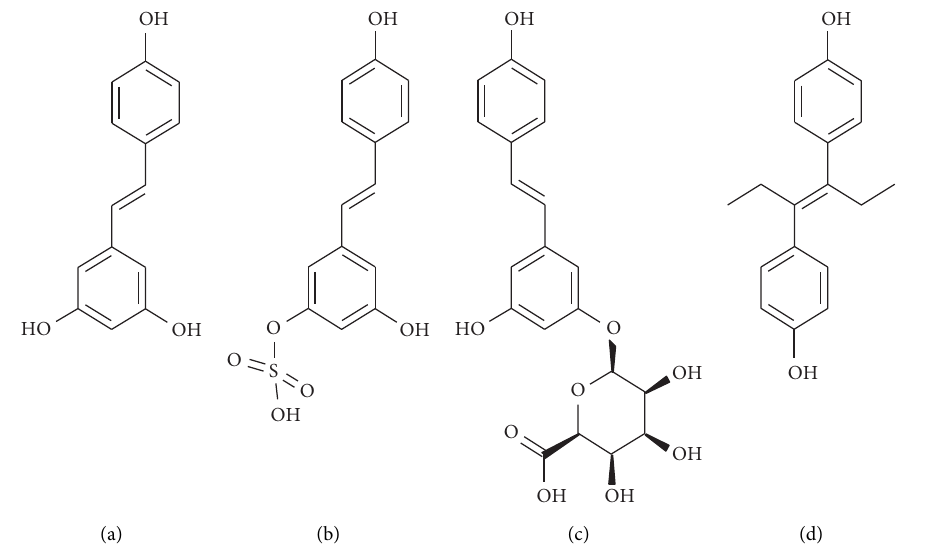
Figure 1: The molecular structures for trans-resveratrol (a), trans-resveratrol-3-sulfate salt (b), trans-resveratrol-3-o- β -glucuronide (c), and diethylstilbestrol